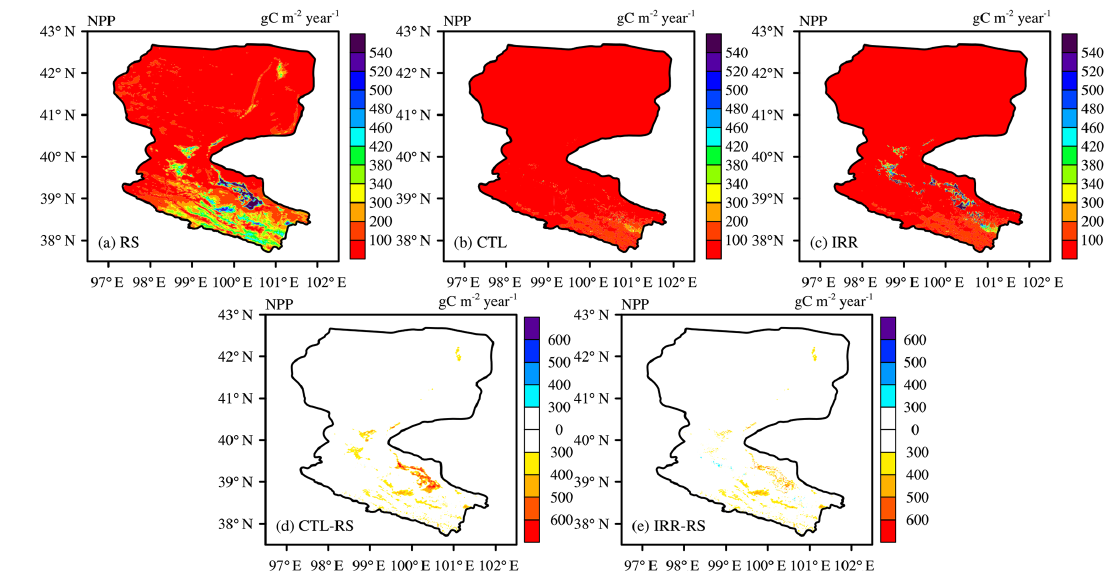
Figure 7. Climatological NPP distribution from 1998 to 2002 over the Heihe River basin obtained from (a) remote sensing, (b) CTL, (c) IRR, (d) CTL remote sensing, and (e) IRR remote